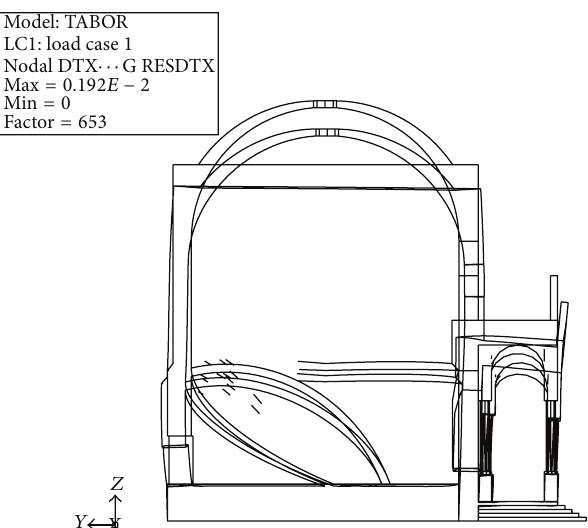
Figure 15: Chapel XVII deformed